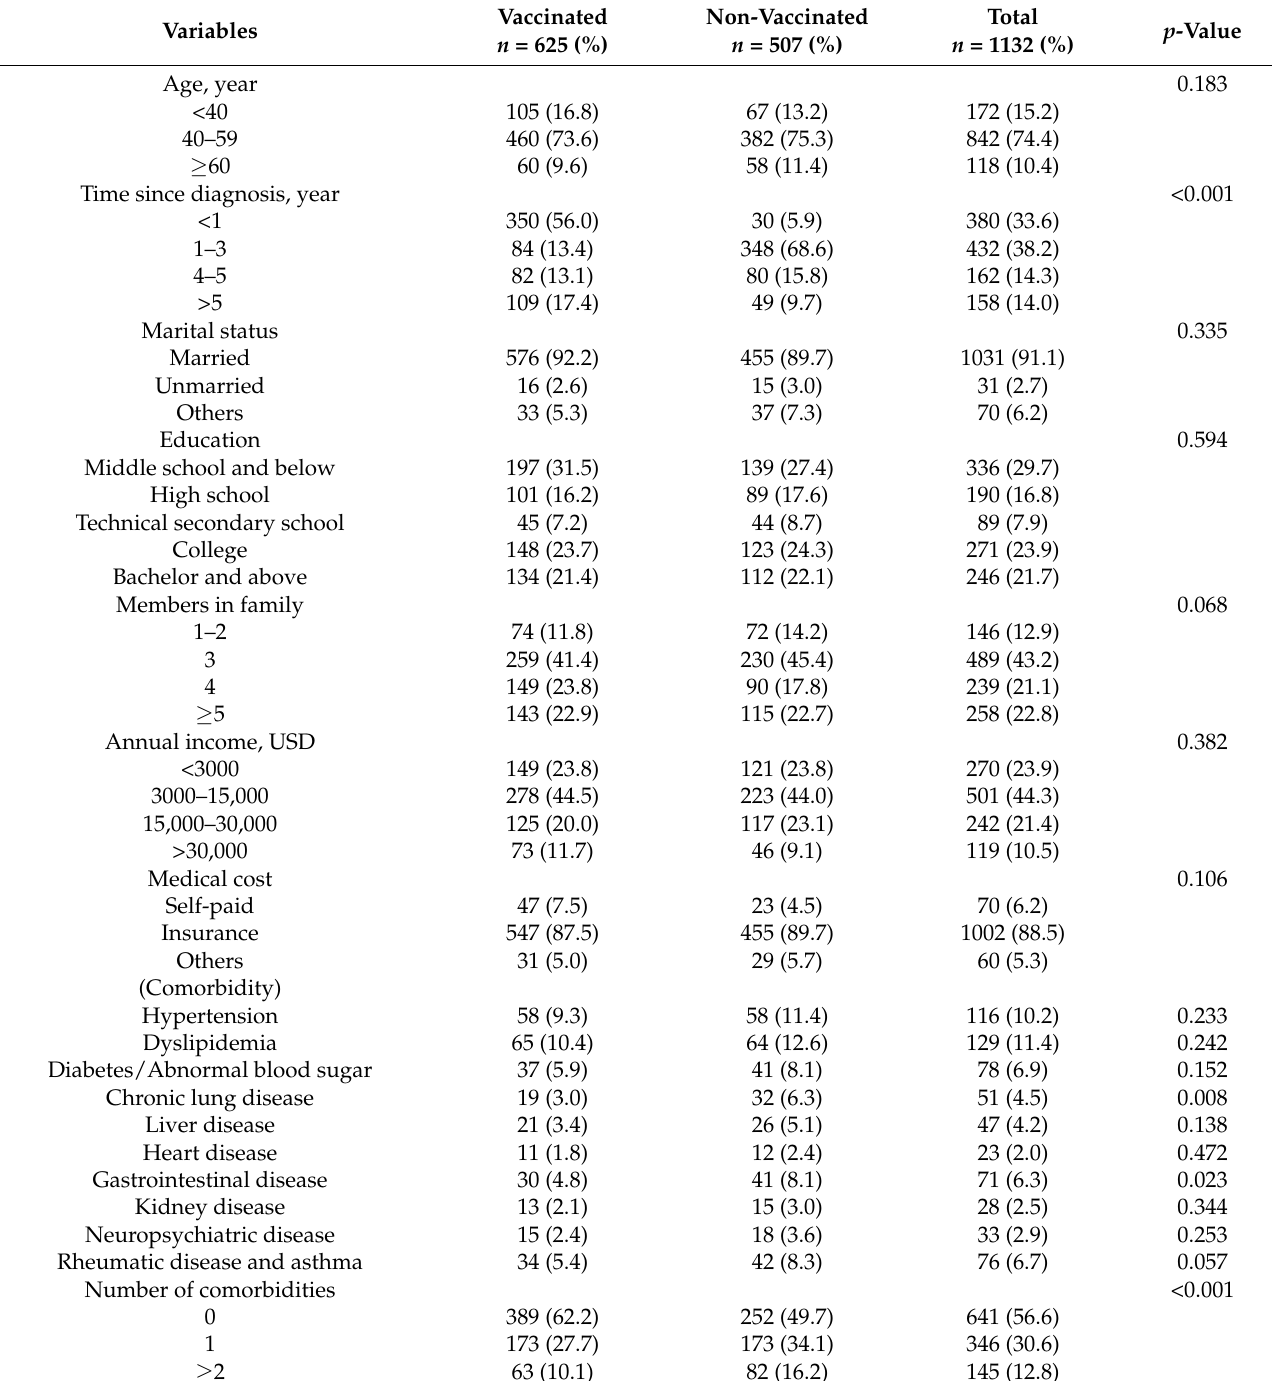
Table 1. Baseline characteristics of